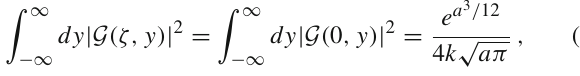
Fig. 1 Contour plot for | G (ζ, y ) | , with G given in Eq. (5), in terms of normalized k ζ and ky variables, for different values of a . a Plot for a = 1. b Plot a = 2. For both cases the red solid line shows the dynamical trajectory of the position of local maxima lobes of the wavepacket, which shows acceleration in the ζ − y plane. The colors get brighter as the value of | G (ζ, y ) |